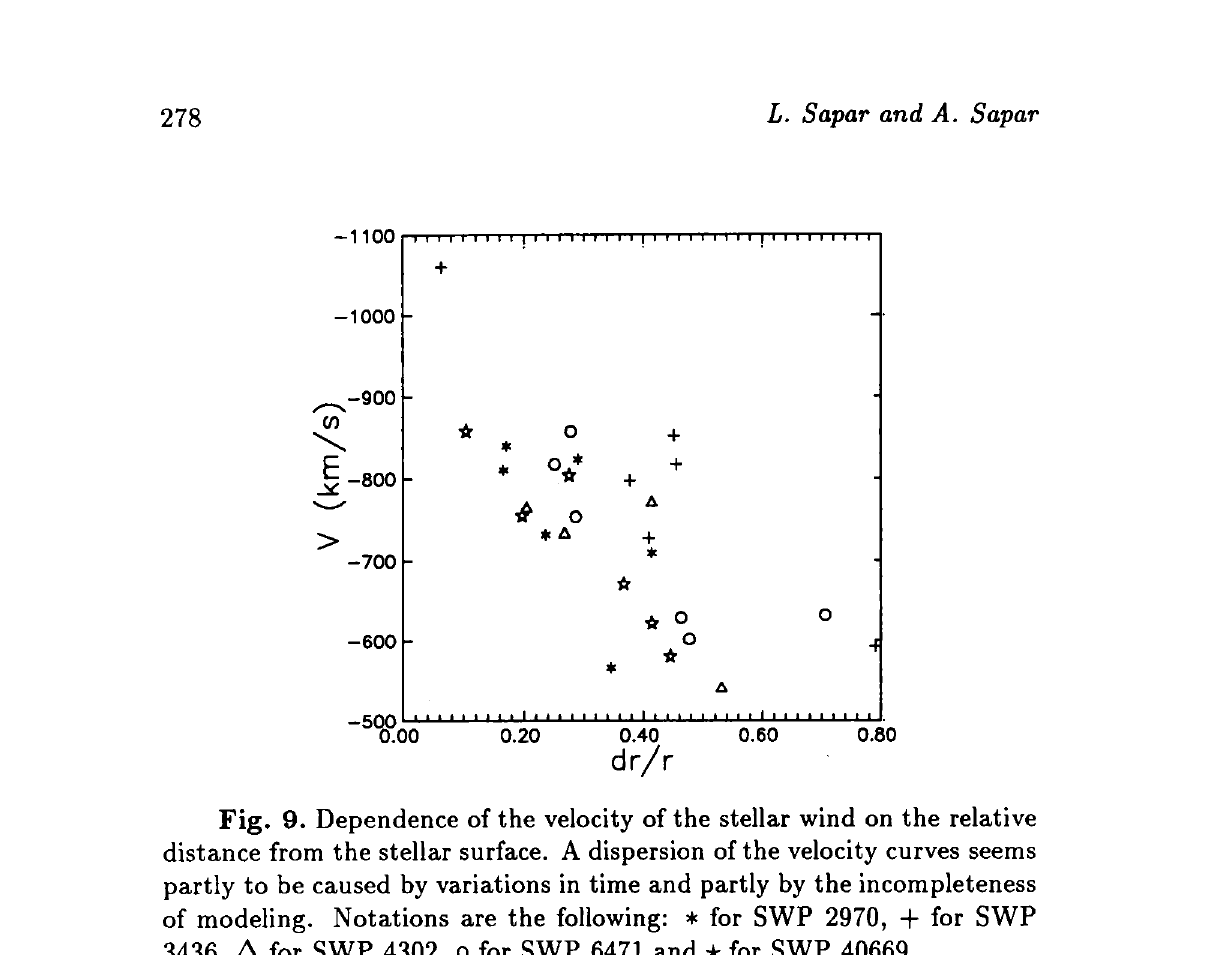
F i g. 9. Dependence of the velocity of the stellar wind on the relative distance from the stellar surface. A dispersion of the velocity curves seems partly to be caused by variations in time and partly by the incompleteness of modeling. Notations are the following: * for SWP 2970, + for SWP 3436, A for SWP 4302, o for SWP 6471 and * for SWP